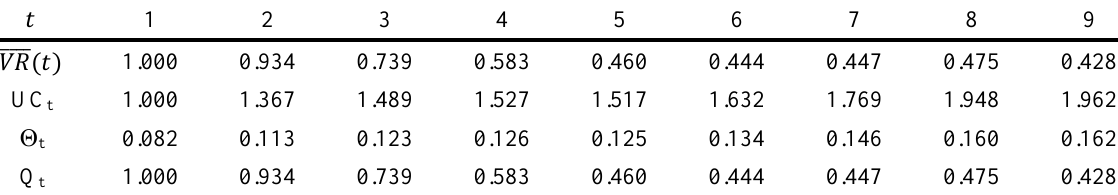
Table 3. Computing Uncertainty Coefficients and risk premiums for Oil